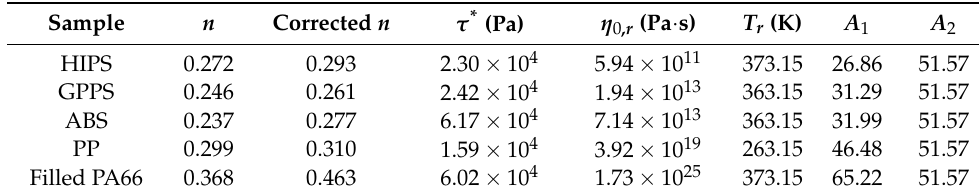
Table 2. Cross-WLF model parameters for polymer melts.